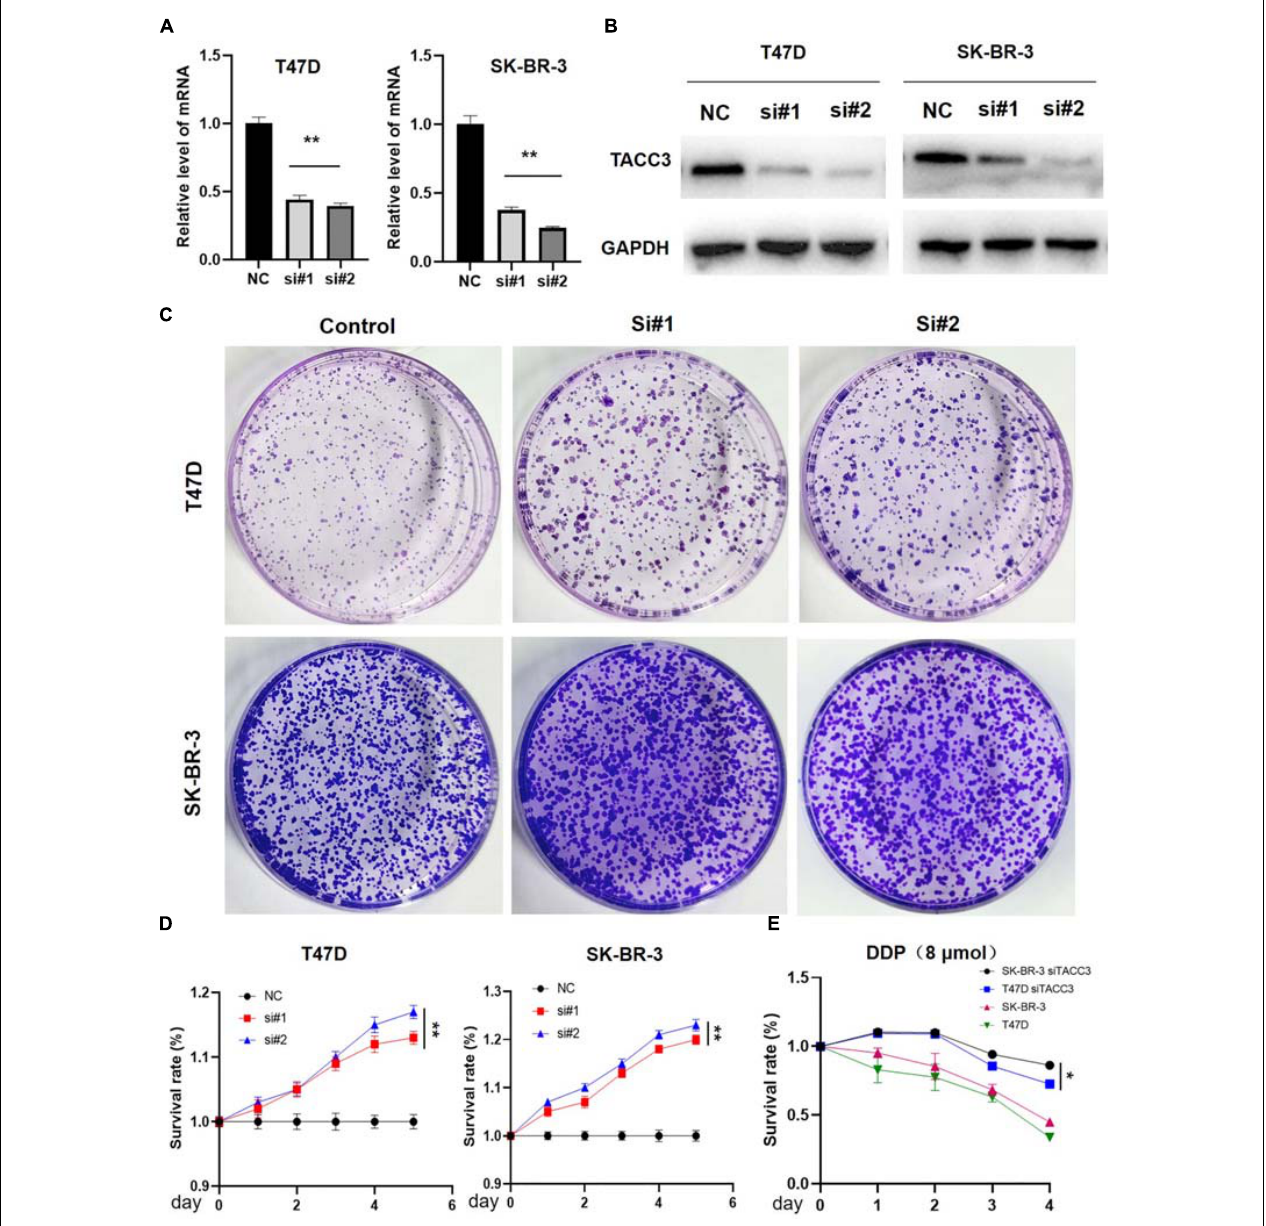
FIGURE 5 | TACC3 knockdown promotes tumor formation in the T47D and SK-BR-3 cell lines. (A) Verification of TACC3 in T47D and SK-BR-3 cells by quantitative RT-PCR. (B) Verification of TACC3 in T47D and SK-BR-3 cell lines by quantitative Western blot analysis. (C) Colony formation assay for assessing the cell proliferation of siTACC3-treated cells. (D) Growth curves of T47D and SK-BR-3 cell before and after TACC3 gene knockdown. (E) The effect of DDP 8 µ mol on the viability of breast cancer cells. All assays were performed in biological triplicate. Data are shown as mean ± S.E.M. **compared with NC, p < 0.01. *compared with NC, p < 0.05. P -values are calculated by Student’s t